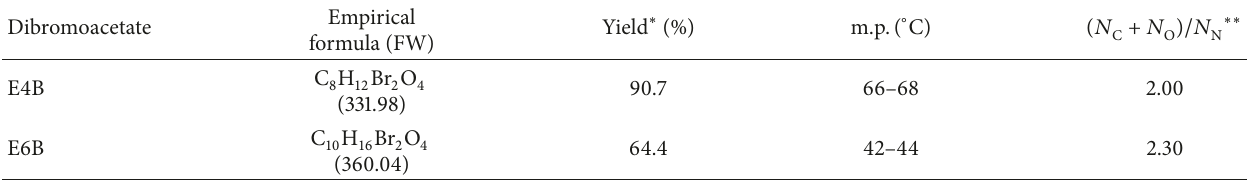
Table 2: The characteristics of di-(bromoacetic acid) alkylene diesters.